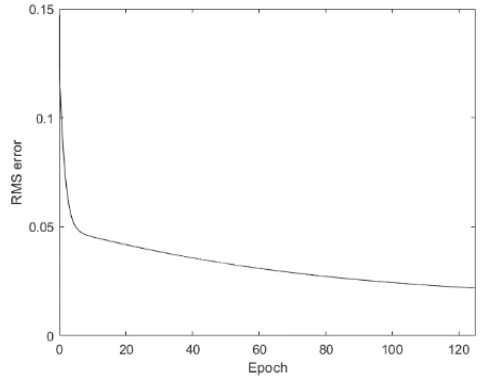
Figure 27. Learning curve of the FNFN controller in the water bath system.